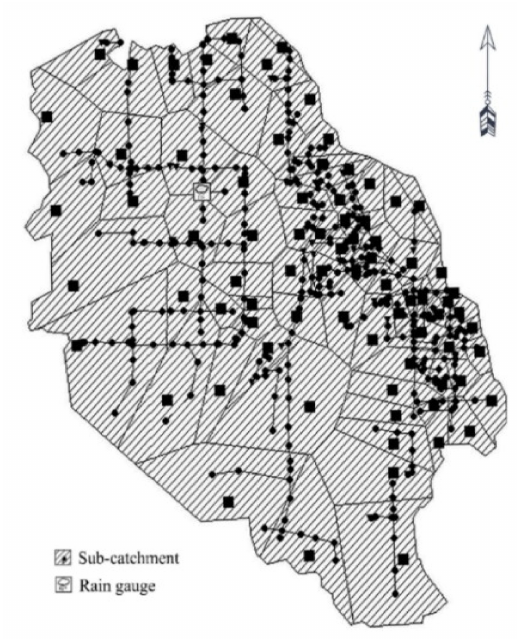
Figure 5. The sub-catchments and stormwater system of the study